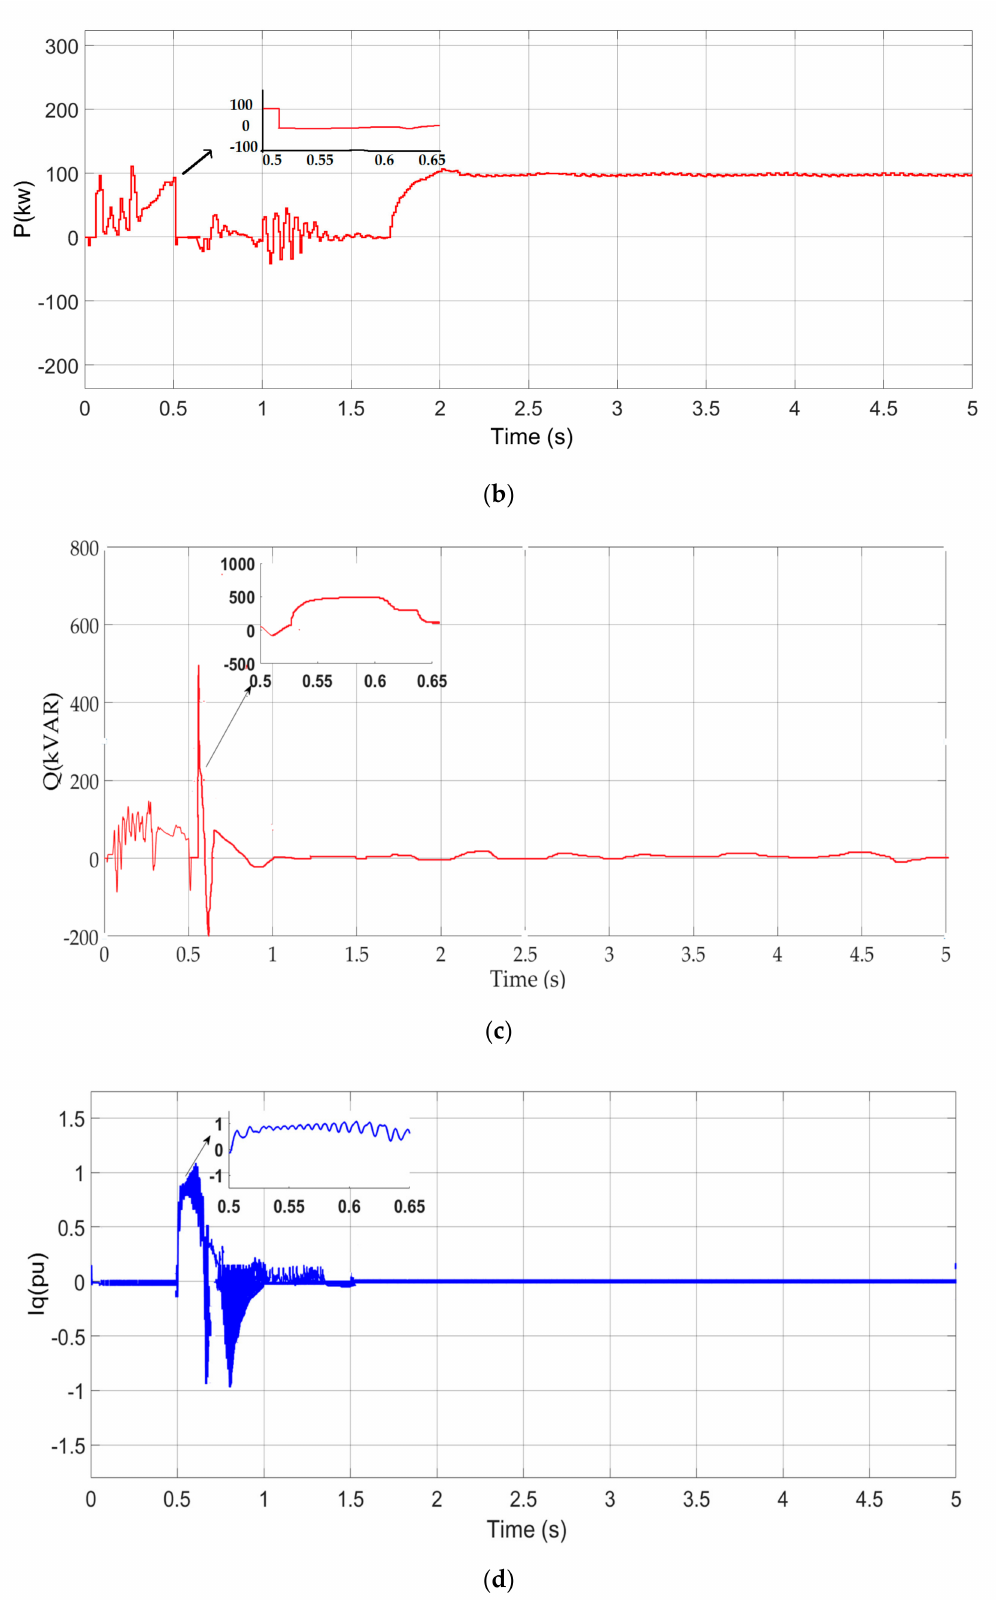
Figure 10. Simulation results of the proposed control under a symmetrical (3LG) fault. ( a ) DC-link voltage (DCL), ( b ) active power (P), ( c ) reactive power (Q), ( d ) reactive current (I q